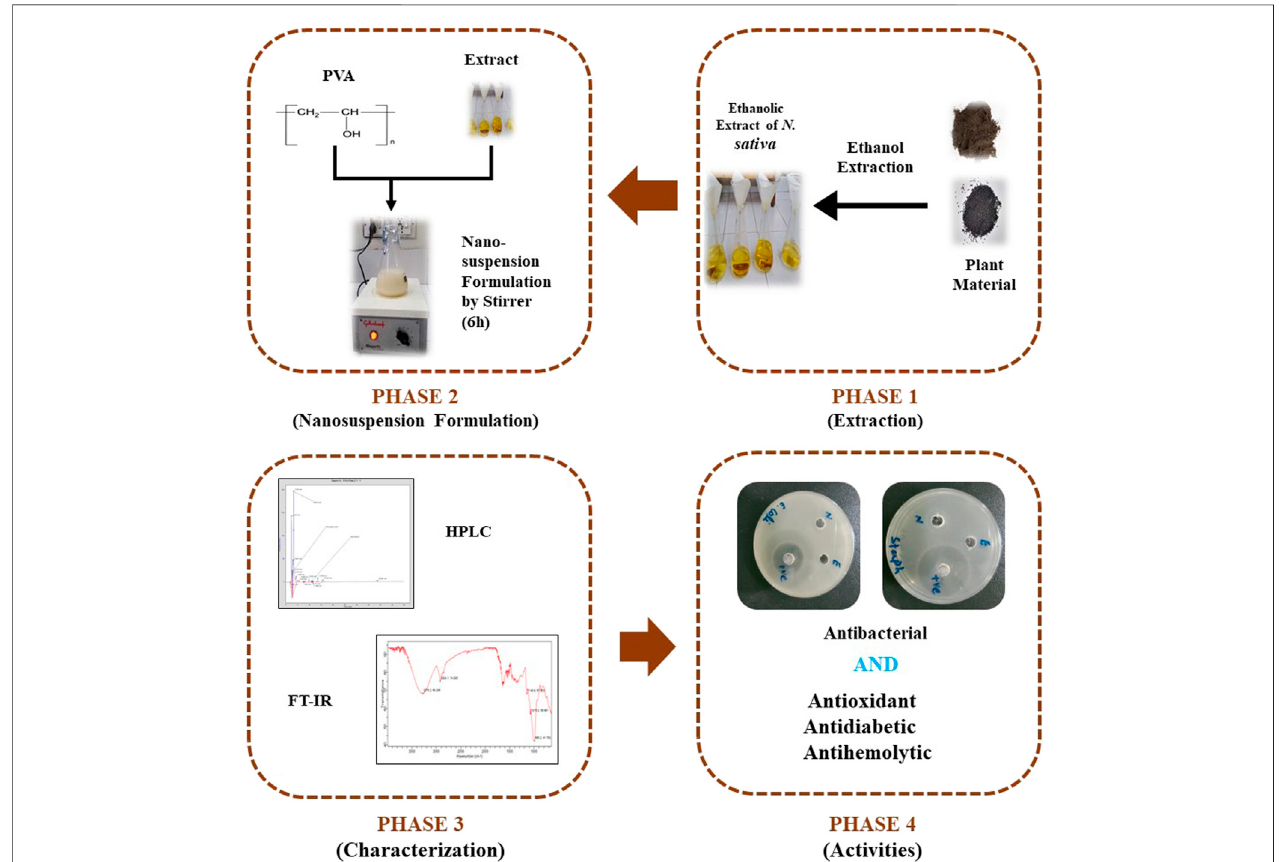
FIGURE 1 | Principle phase of searching of bioactivities of Nigella sativa L. nanosuspension.